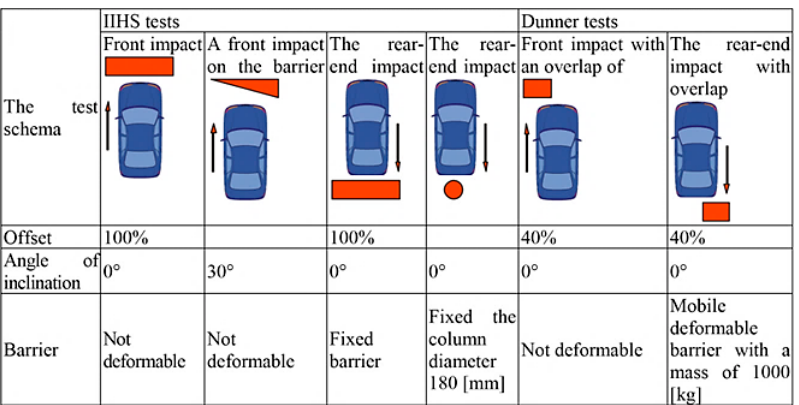
Figure 1. Requirements for low-speed collisions by the Insurance Institute for Highway Safety (IIHS) and Dunner tests.